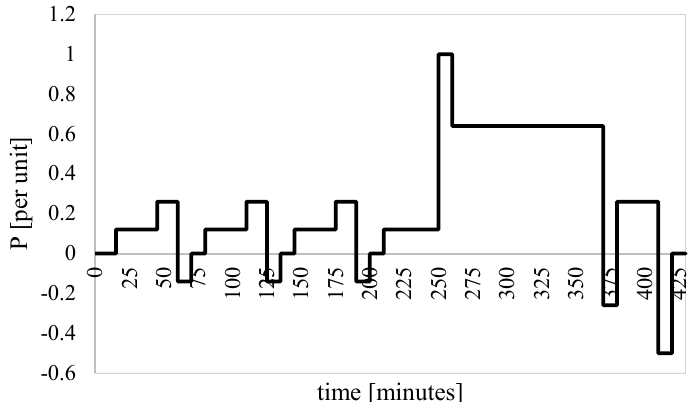
Figure 7. Power setpoints for the verification test proposed.